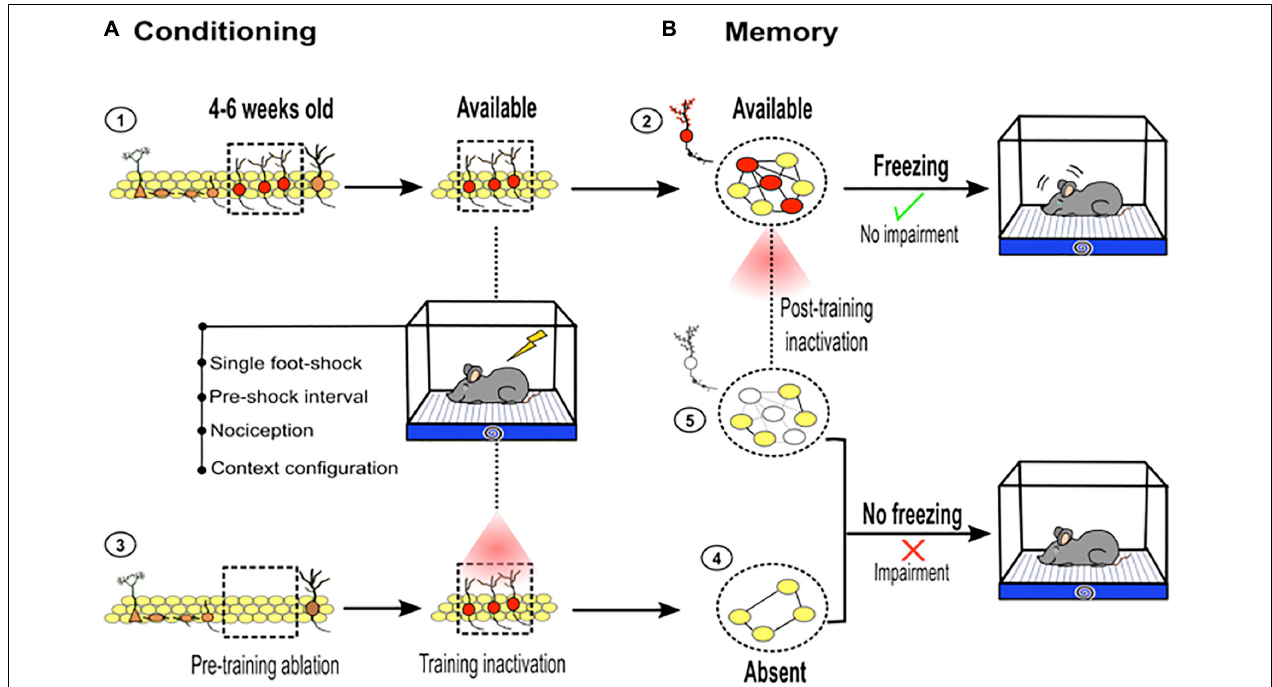
FIGURE 3 | Adult hippocampal neurogenesis and contextual fear learning and memory. (A) (cid:192) Immature new neurons between 4 and 6 weeks old (red, inside dotted square) are particularly important for hippocampal memory function. Immature new neurons available at the time of the training become a part of the memory trace: (cid:193) dotted circle, young neurons (red) connected (black lines) with mature neurons (yellow). However, if they are absent before training or optogenetically silenced during conditioning (cid:194) , their contribution to the memory trace is restricted (cid:195) . (B) As part of the memory trace, young neurons contribute to an adequate memory retrieval, which is reflected by freezing behavior. Pretraining ablation or silencing of new neurons during conditioning, impairs memory retrieval, which is reflected by diminished freezing behavior. If immature new neurons are silenced during retrieval (cid:196) , memory impairment is observed (diminished freezing). This highlights the role of immature new neurons between 4 and 6 weeks old as a critical component of memory